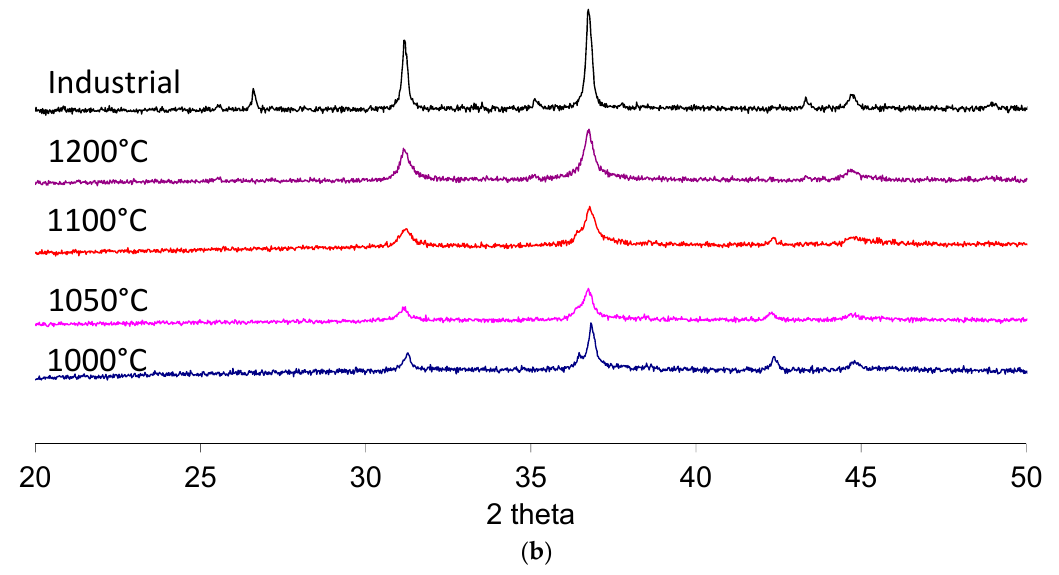
Figure 4. X-Ray diffraction patterns of powders calcined at 1000–1200 °C by different techniques: ( a ) conventional heating in a muffle furnace; ( b ) microwave heating, compared to the industrial standard pigment.